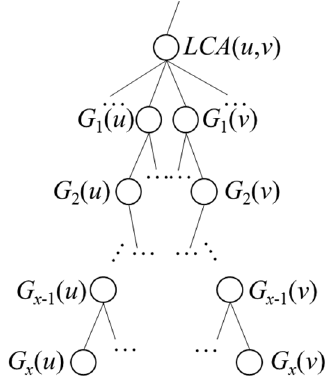
Figure 6. G + -tree nodes passed through from u to v .